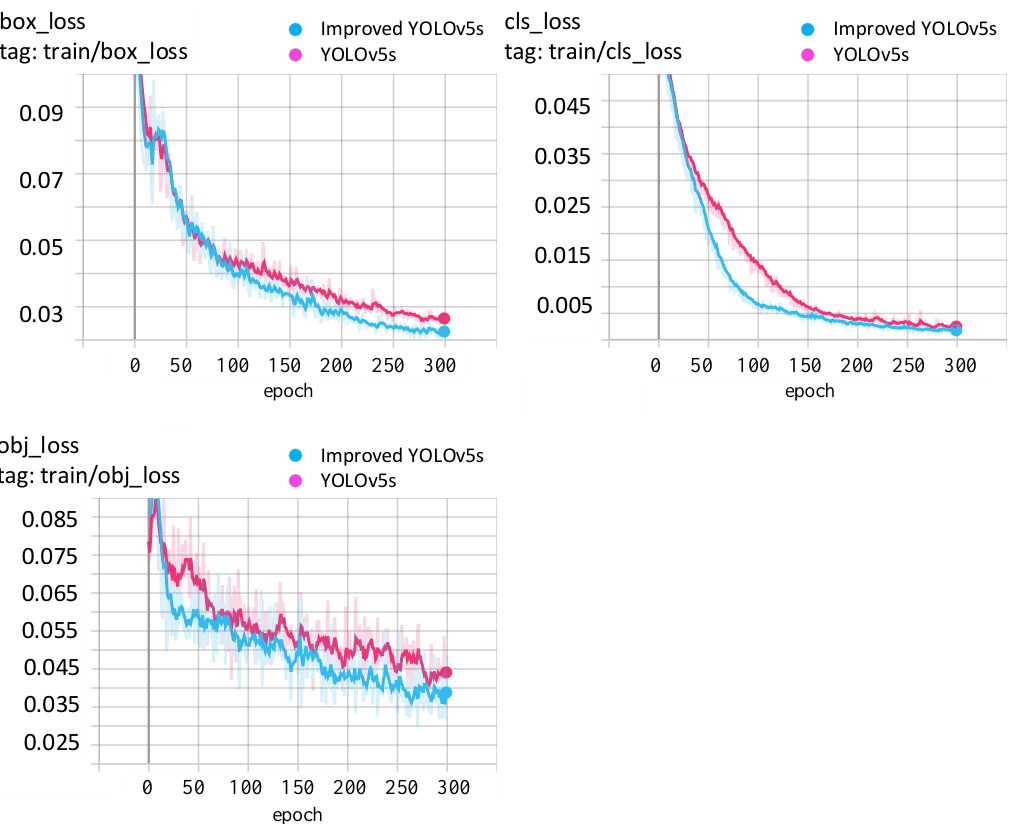
Figure 10. The loss function comparison diagram includes box_loss, cls_loss and obj_loss.